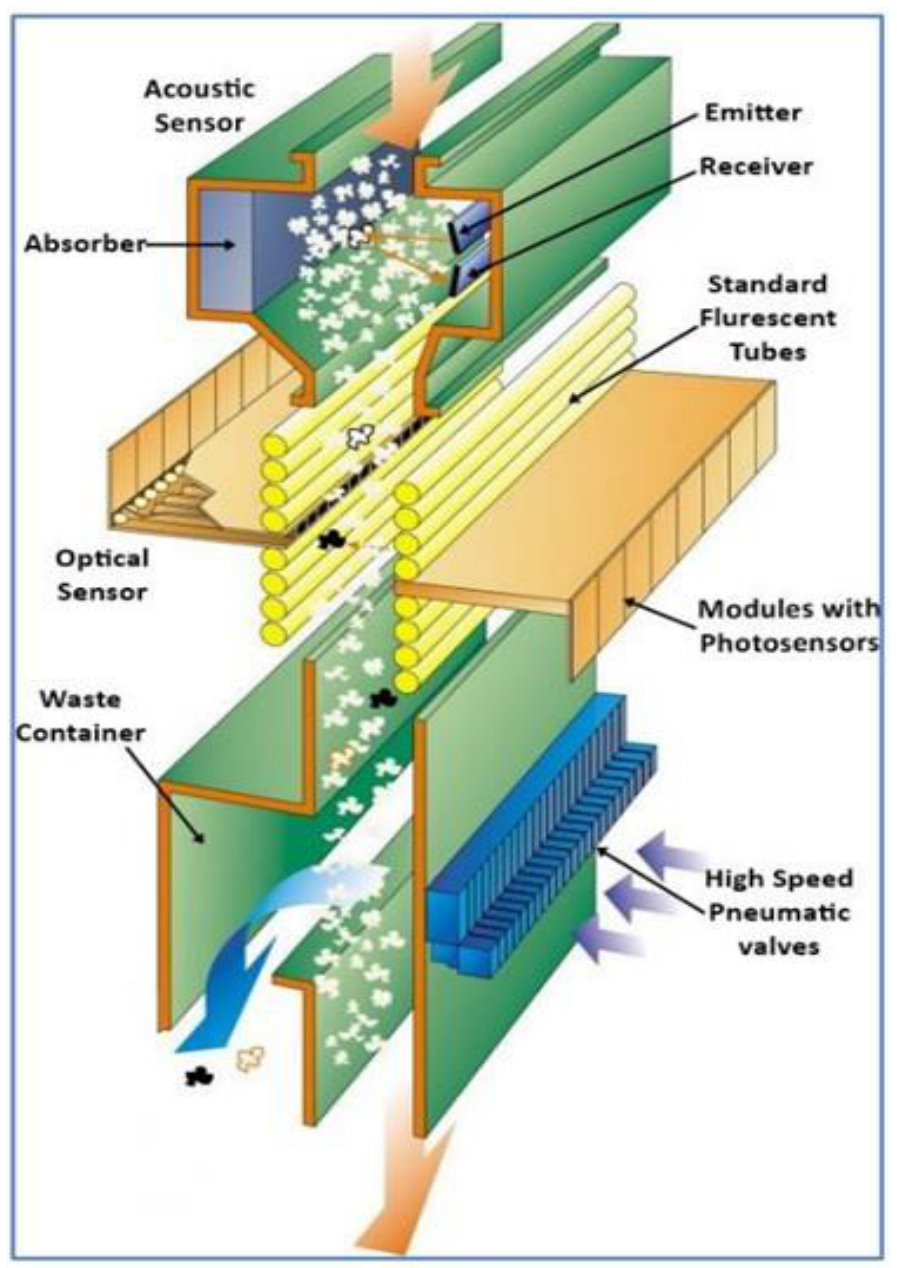
Figure 7. Internal structure and arrangement of components of the Loptex sorter. The black and dark-colored substances are detected as contaminants (adopted with permission from [95]).